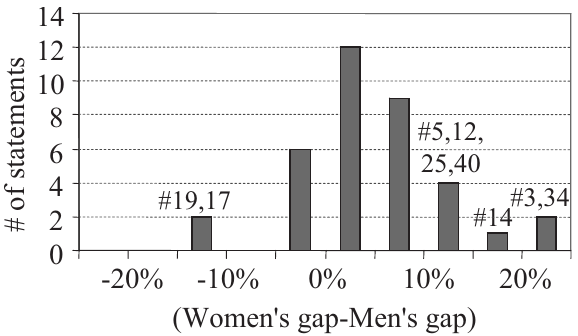
FIG. 9. Difference between women’s and men’s gaps for indi- vidual statements for the Physics I-Alg course. For many state- ments, the gap between women’s “physicist” and “personal” pre scores is slightly larger than the gap between men’s “physicist” and “personal”